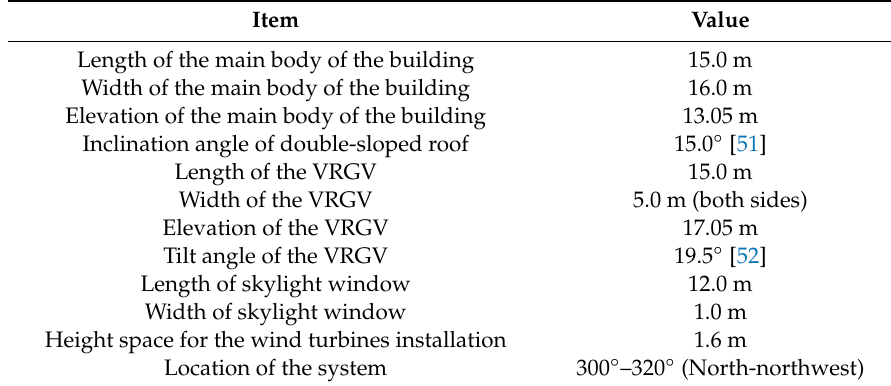
Figure 3. Overall structure layout. Table 1. Specific parameters of the hybrid renewable energy harvester system.